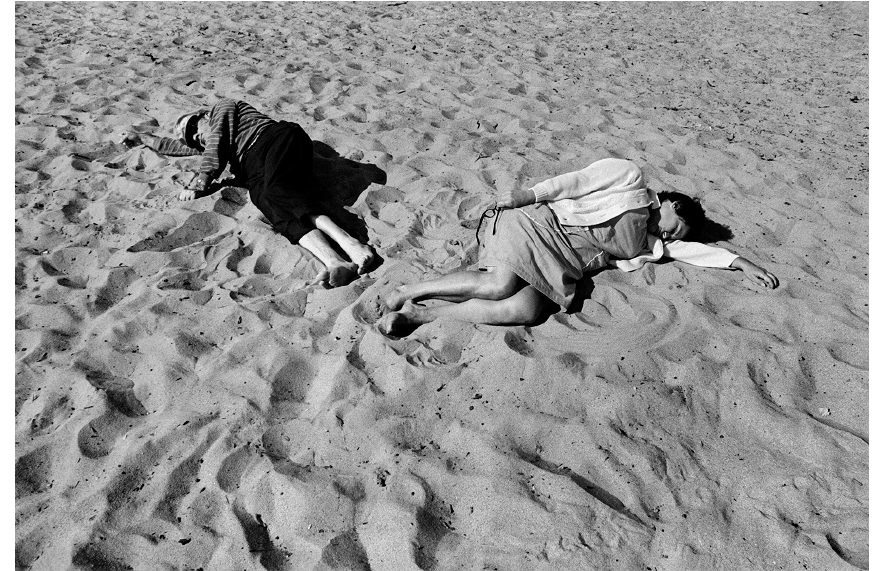
Figure 11. Anthony Hernandez Santa Monica # 14 (1969), © Anthony Hernandez.